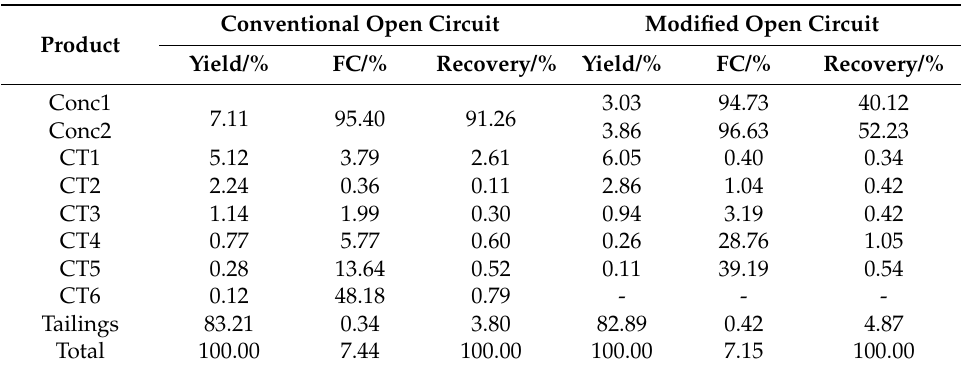
Table 5. Flotation results of the conventional and the modified open circuit